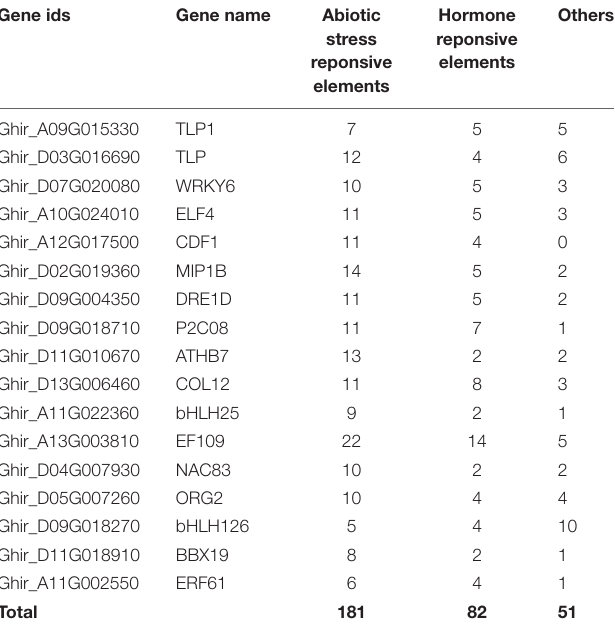
TABLE 3B | Cis -regulatory elements of identified hub genes in salt stress condition.